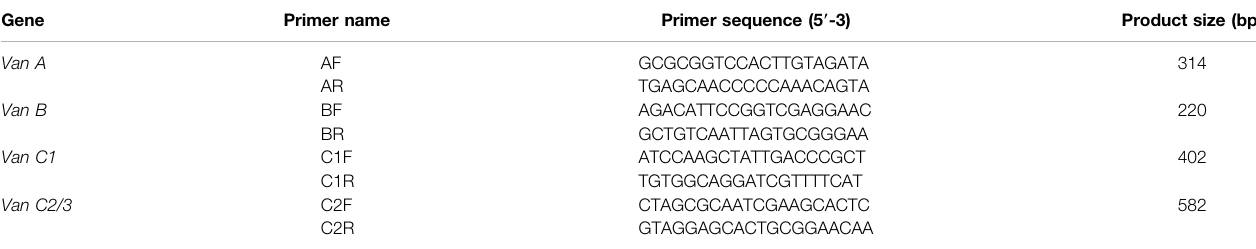
TABLE 2 | Primers for detection of vancomycin resistance